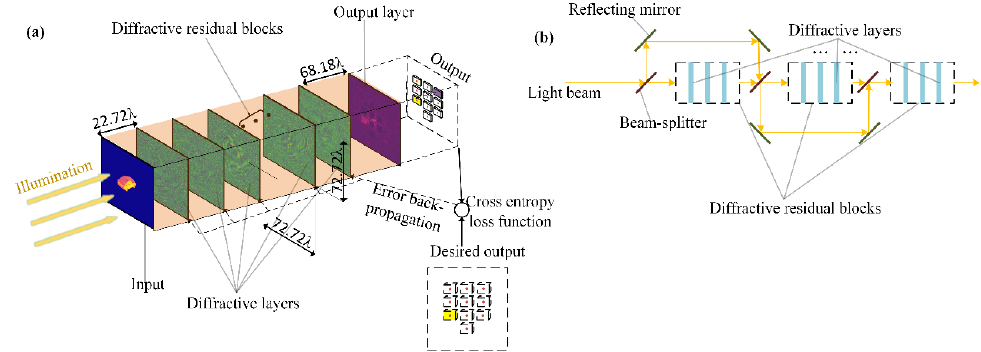
Figure 6. An essential BL of the mr- MDA was designed as a series of diffractive layers with some diffractive blocks. ( a ) Basic architecture of an essential BL. ( b ) Core architecture of the diffractive residual blocks in the BL.